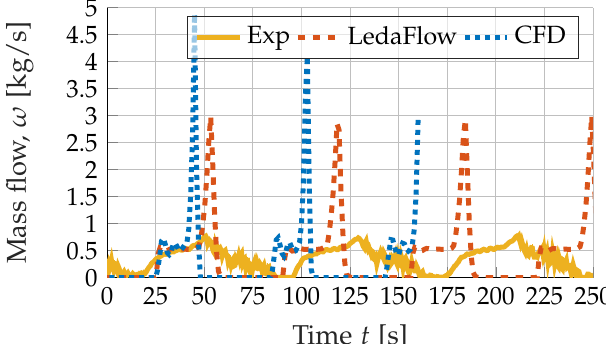
Figure 10. Comparison of CFD, LedaFlow and experimental results for the topside mass flow